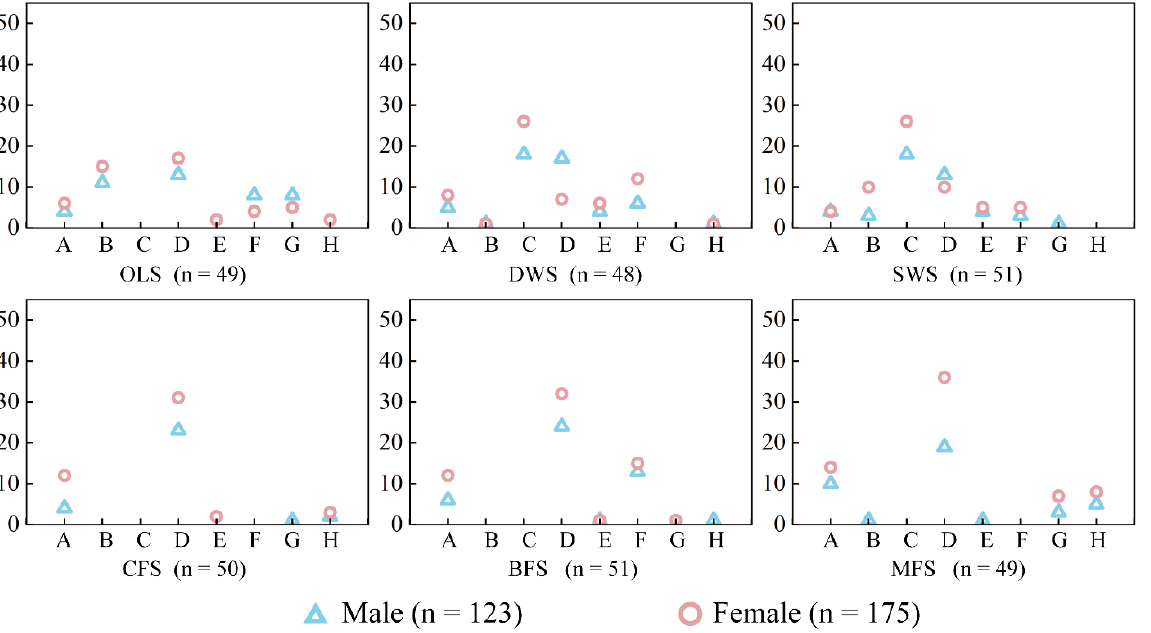
Table 6. Spearman correlation analysis among physiological response changes, emotional response changes, and preferences.